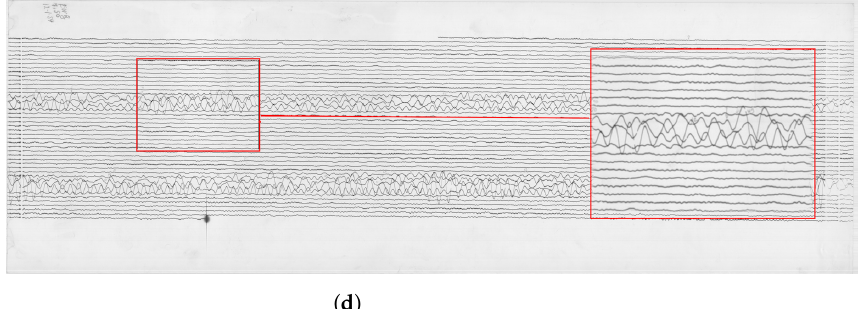
Figure 4. Examples of the raw data: old analog seismograms recorded by Uccle seismic station, Belgium, 1954, scanned and saved as TIFF files. Some images have visible distortions and de- fects. ( a ) Empty records between the lines of seismic traces with enlarged fragment of seismogram. Here: UCC19540106Gal_N_0811.TIFF. ( b ) Partially spotted image caused by storage with enlarged fragment of seismogram. Here: UCC19540107Gal_N_0815.TIFF. ( c ) Continuous noise dark back- ground on the image with blurred traces which causes lack of contrast for the automated image recognition. Here: UCC19540108Gal_N_0815.TIFF. ( d ) Overlapped traces of a very large event which cause a problem during vectorising with selected enlarged fragment of seismogram. Here: